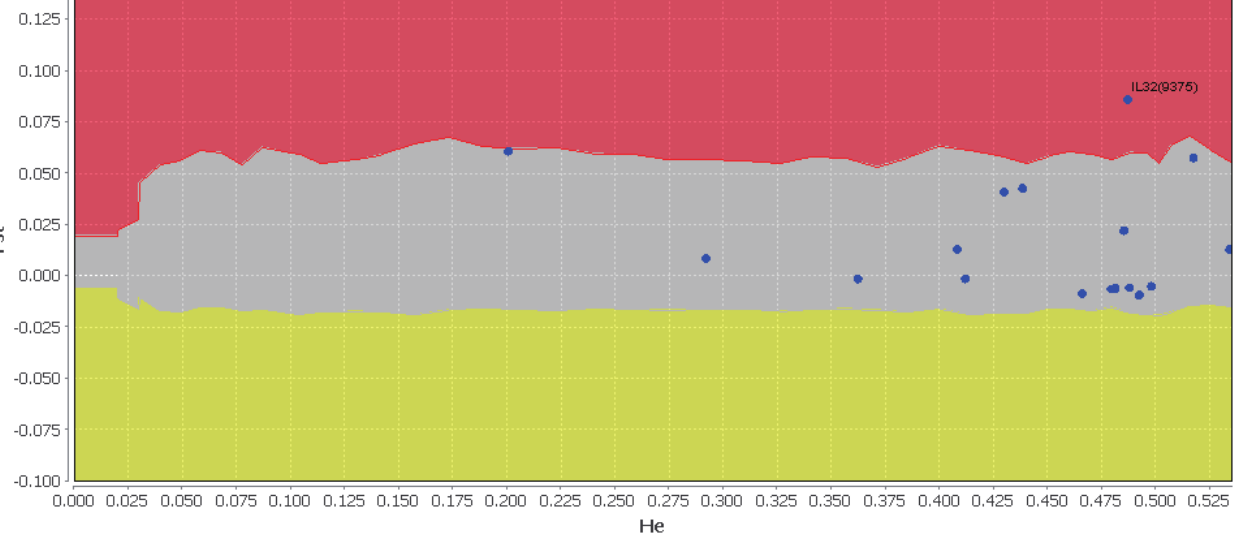
, fixation index; He, ST